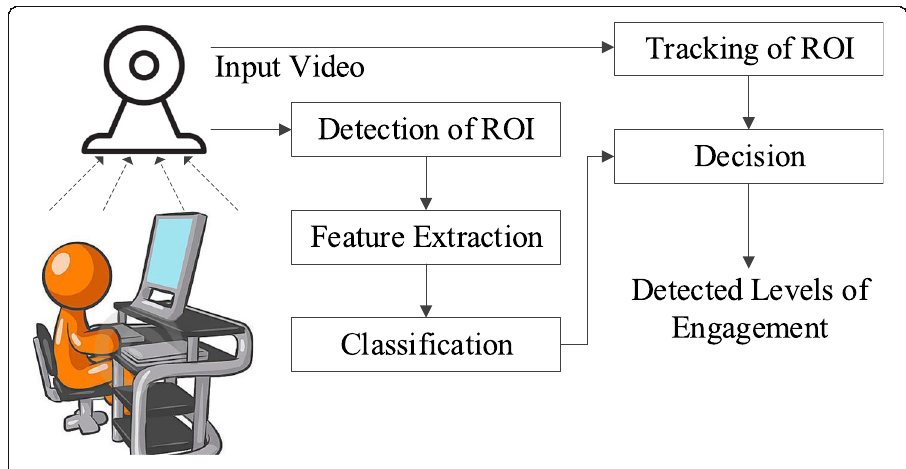
Fig. 2 A generic framework for computer vision based engagement detection